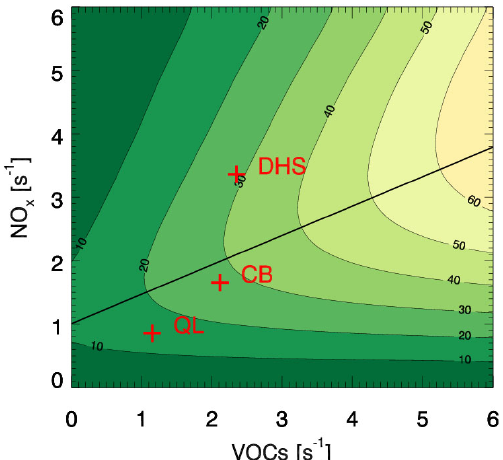
Figure 12. The ozone production rate ( P (O 3 )) contour diagram versus anthropogenic VOCs (AVOCs) and NO x using the empirical kinetic modeling approach at CB, DHS, and QL